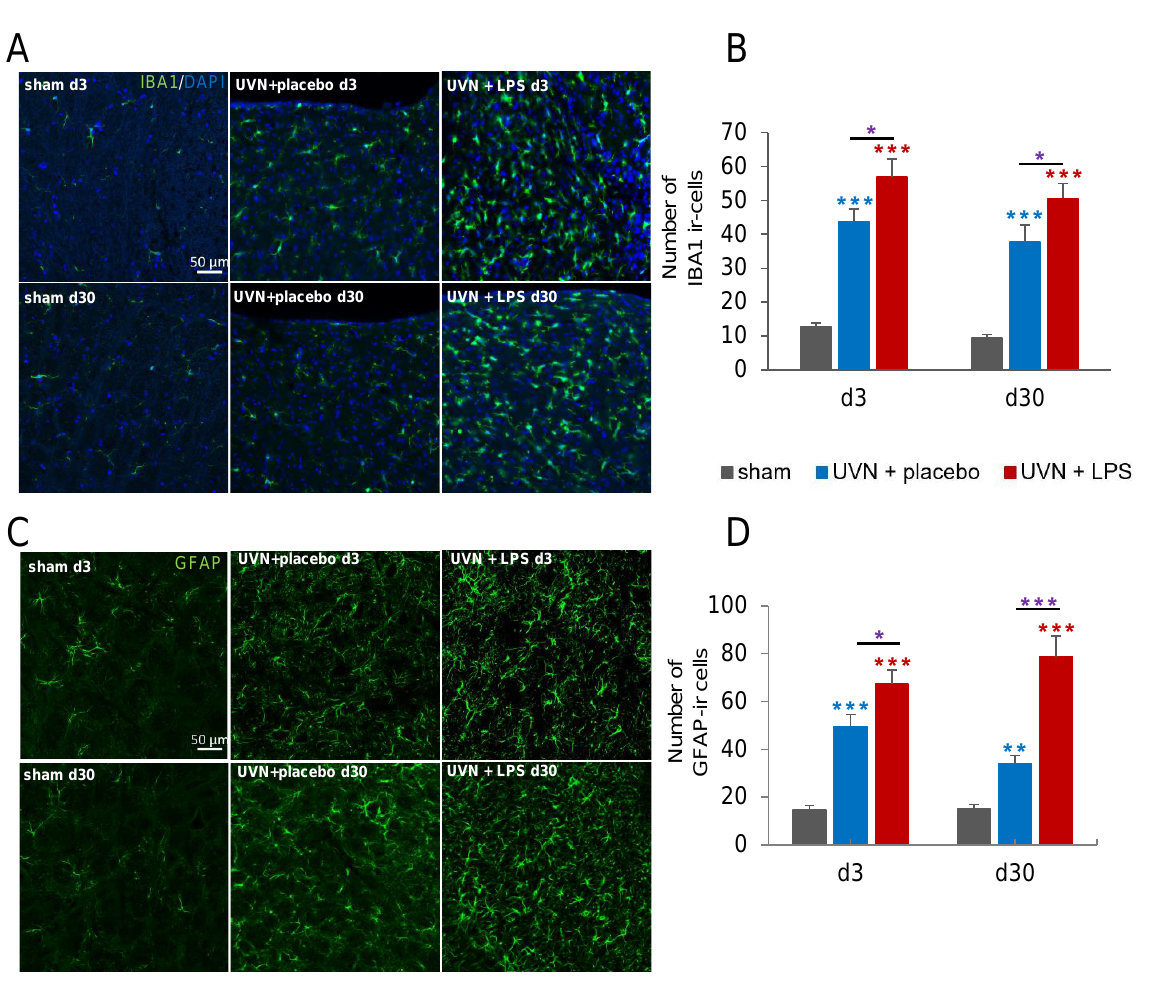
Figure 2. Glial reactions in the medial vestibular nuclei (MVN) are enhanced by the acute LPS treatment after UVN. ( A ) Confocal visualization of microglial cells immunostained with IBA1 and DAPI (nucleus) in the left MVN of a representative animal in sham, UVN+placebo, and UVN+LPS groups at d3 and d30. ( B ) Quantification of the number of IBA1 immunoreactive (ir) cells in the left MVN at d3 and d30. ( C ) Confocal visualization of astrocytes immunostained with GFAP in the left MVN of a representative animal in sham, UVN+placebo, and UVN+LPS groups at d3 and d30 post-UVN. ( D ) Quantification of the number of GFAP-ir cells in the left MVN at d3 and d30. Scale bar, 50 µ m. Histograms represents the mean number of ir cells, with error bars representing SEM. * p < 0.05; ** p < 0.01; *** p < 0.001, two-way ANOVA, post hoc Tukey: sham and UVN+placebo comparison is indicated by a blue *; sham and UVN+LPS comparison is indicated by a red *; UVN+placebo and UVN+LPS comparison is indicated by a purple